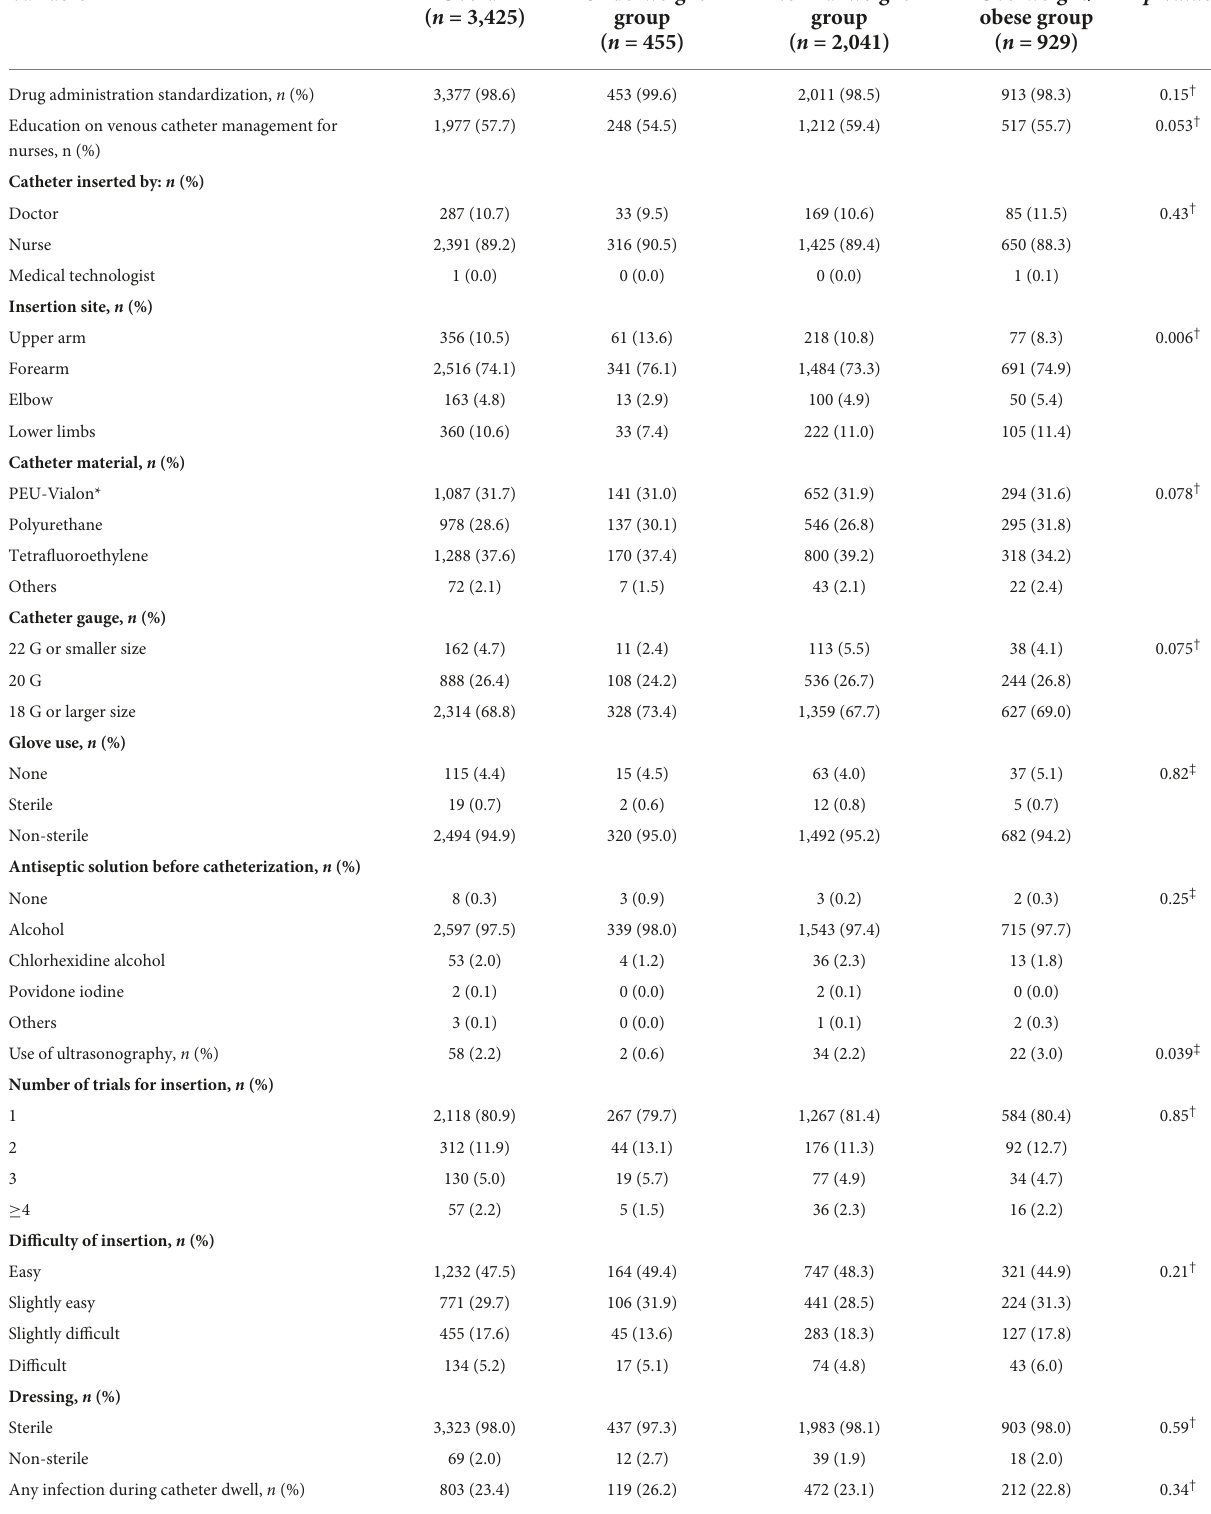
TABLE 2 Peripheral intravenous catheter characteristics during insertion stratified by body mass